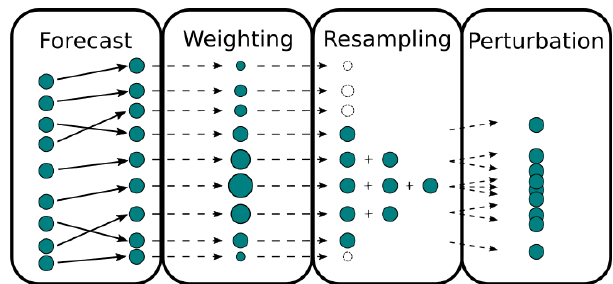
Figure 1. The particle filter principle. In the forecast phase, the dy- namic model ensemble is propagated in time until observations be- come available. Then, the ensemble members are assigned a weight factor based on the residuals between the observations and the according values computed from the model states. Based on the weight, the ensemble is resampled. Members with low weights are disregarded, members with high weights are copied. The ensemble size stays constant. Finally, the model states of the ensemble mem- bers are perturbed, and the next model integration cycle starts with the updated ensemble.